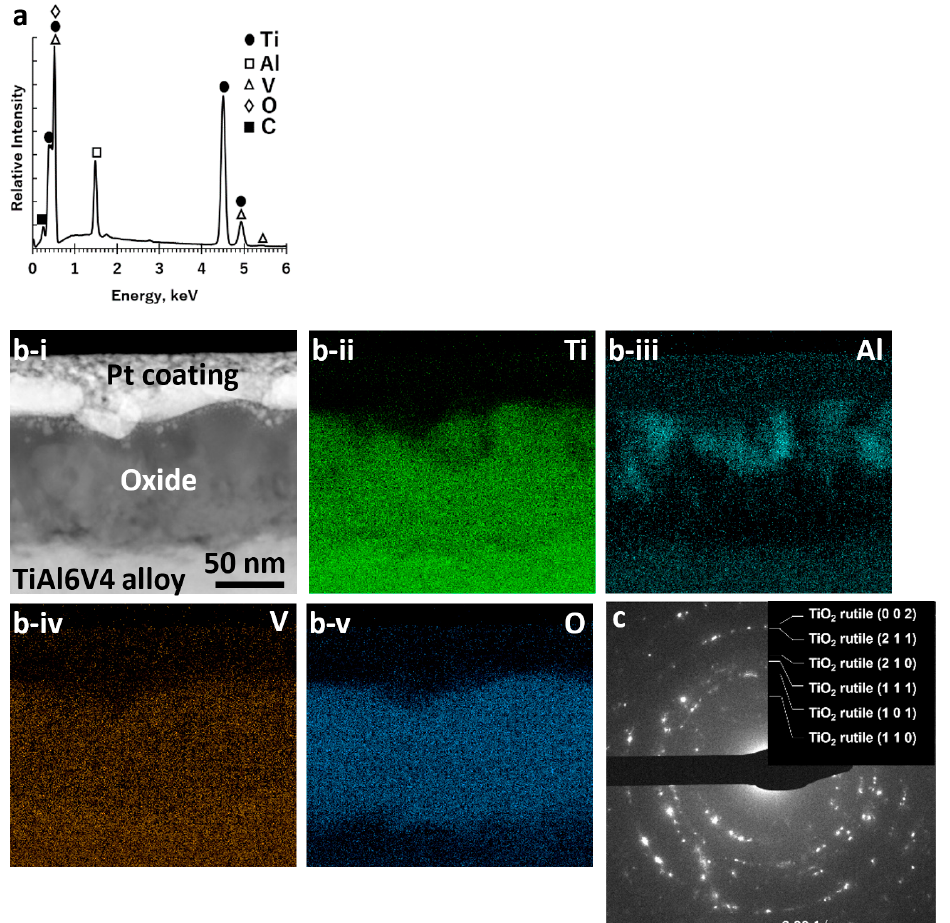
Figure 3. Characterization of a polished DMLS TiAl6V4 specimen after exposure to air at 600 °C for 6 h: ( a ) SEM/EDX spectrum obtained from top-down analysis of the external surface; ( b-i ) cross- sectional STEM image and associated EDX elemental maps for ( b-ii ) titanium, ( b-iii ) aluminium, ( b-iv ) vanadium, and ( b-v ) oxygen, obtained from an ion-milled cross-section at the surface, revealing the Ti-O-rich surface layer; ( c ) SAED pattern, consistent with rutile TiO 2 , obtained from an ion-milled cross-section at the surface.